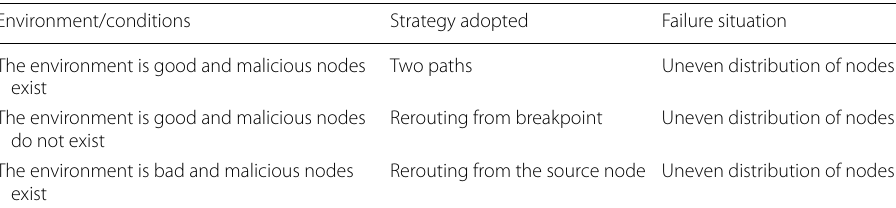
Table 2 Experimental parameters and their configuration Environment/conditions Strategy adopted Failure situation The environment is good and malicious nodes Two paths Uneven distribution of nodes exist Rerouting from breakpoint Uneven distribution of nodes Rerouting from the source node Uneven distribution of